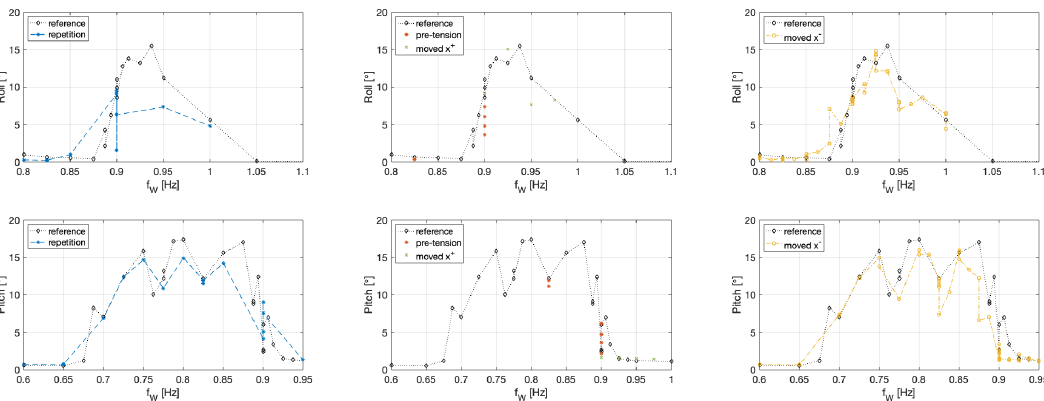
Figure 7. Detailed view of roll ( upper row ) and pitch ( lower row ) presented in Figure 5—the used boundaries for wave frequency f W are limited to focus on a specific frequency band for each